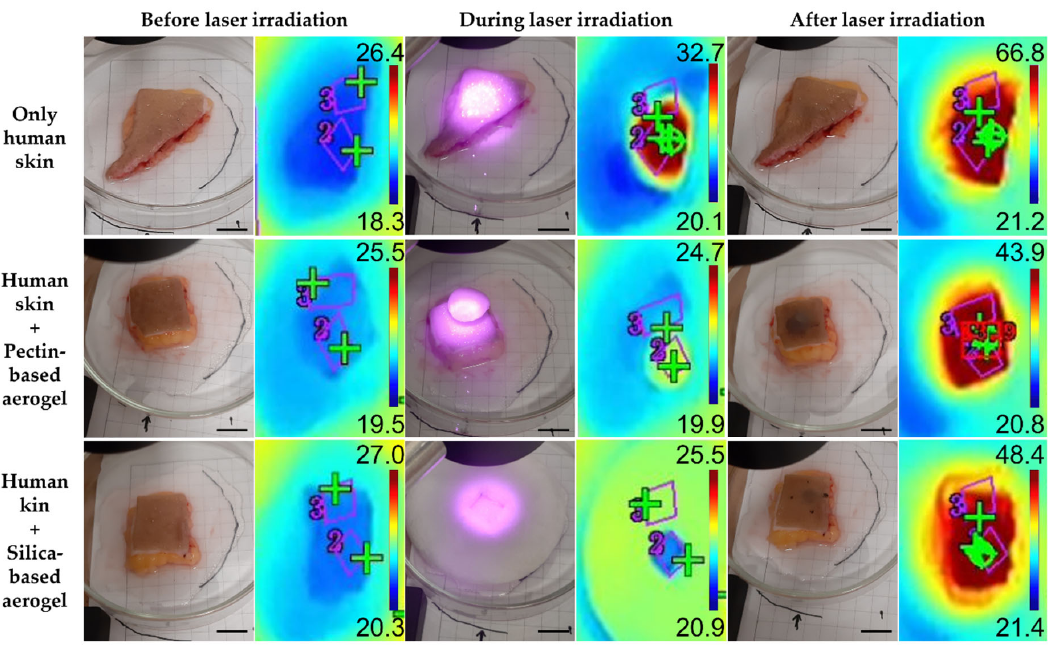
Figure 7. Real and thermal images of human skin ex vivo grafts before, during (after 1 min of irradiation) and after laser irradiation. Scale bar: 1.3 cm.